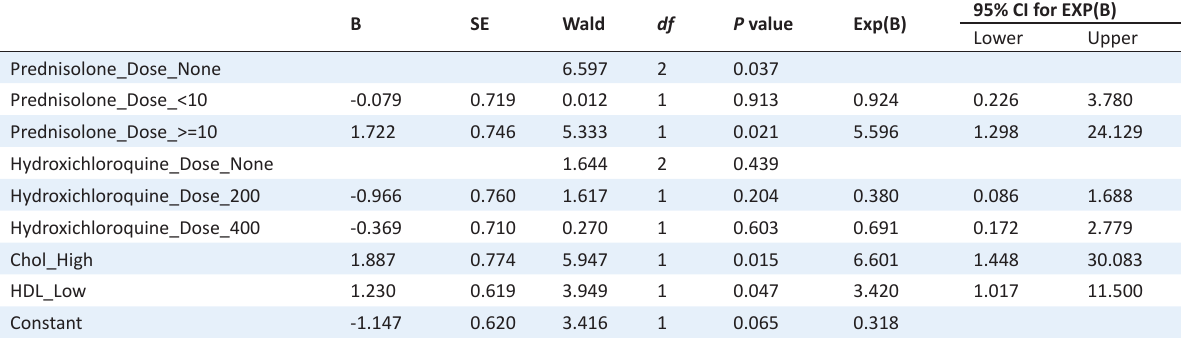
Table 2. The results of logistic regression analysis for having chance of active disease in